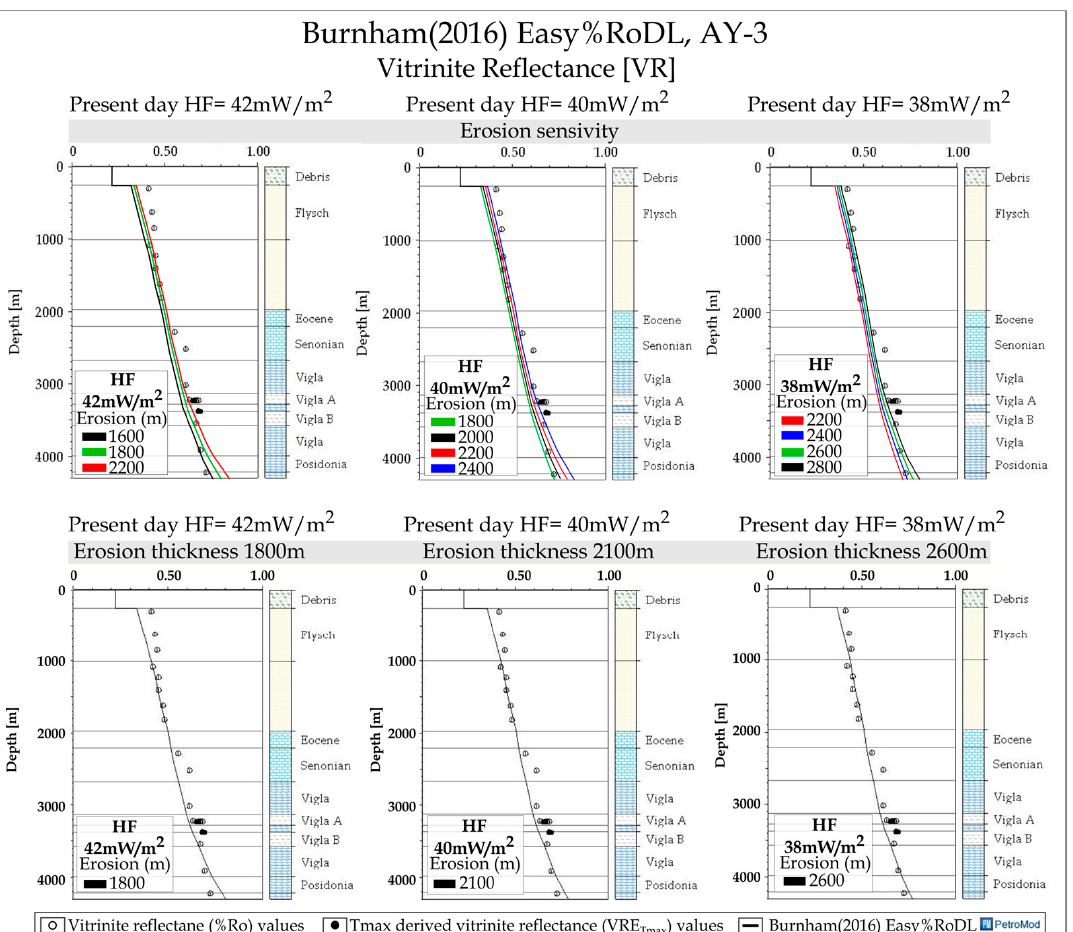
Figure 7. Sensitivity analysis results of the AY-3 model. Top: Changing eroded thickness with constant present-day heat flow (HF) scenarios (42, 40, 38 mW/m 2 ). Bottom: Optimum calibration of the VR for the latter HF values. Depth corresponds to ground level MD [9].